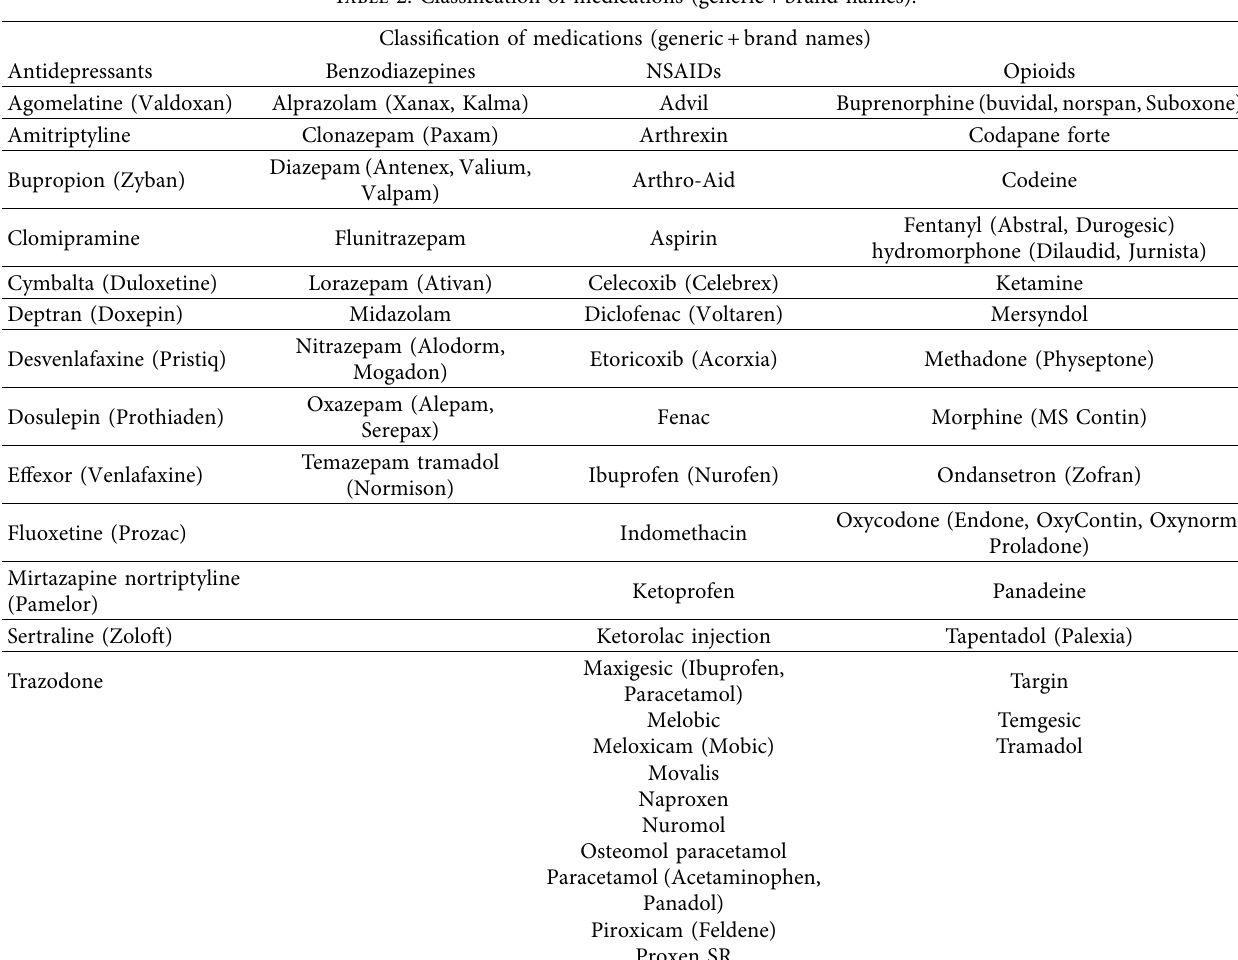
Table 2: Classifcation of medications (generic+brand names).